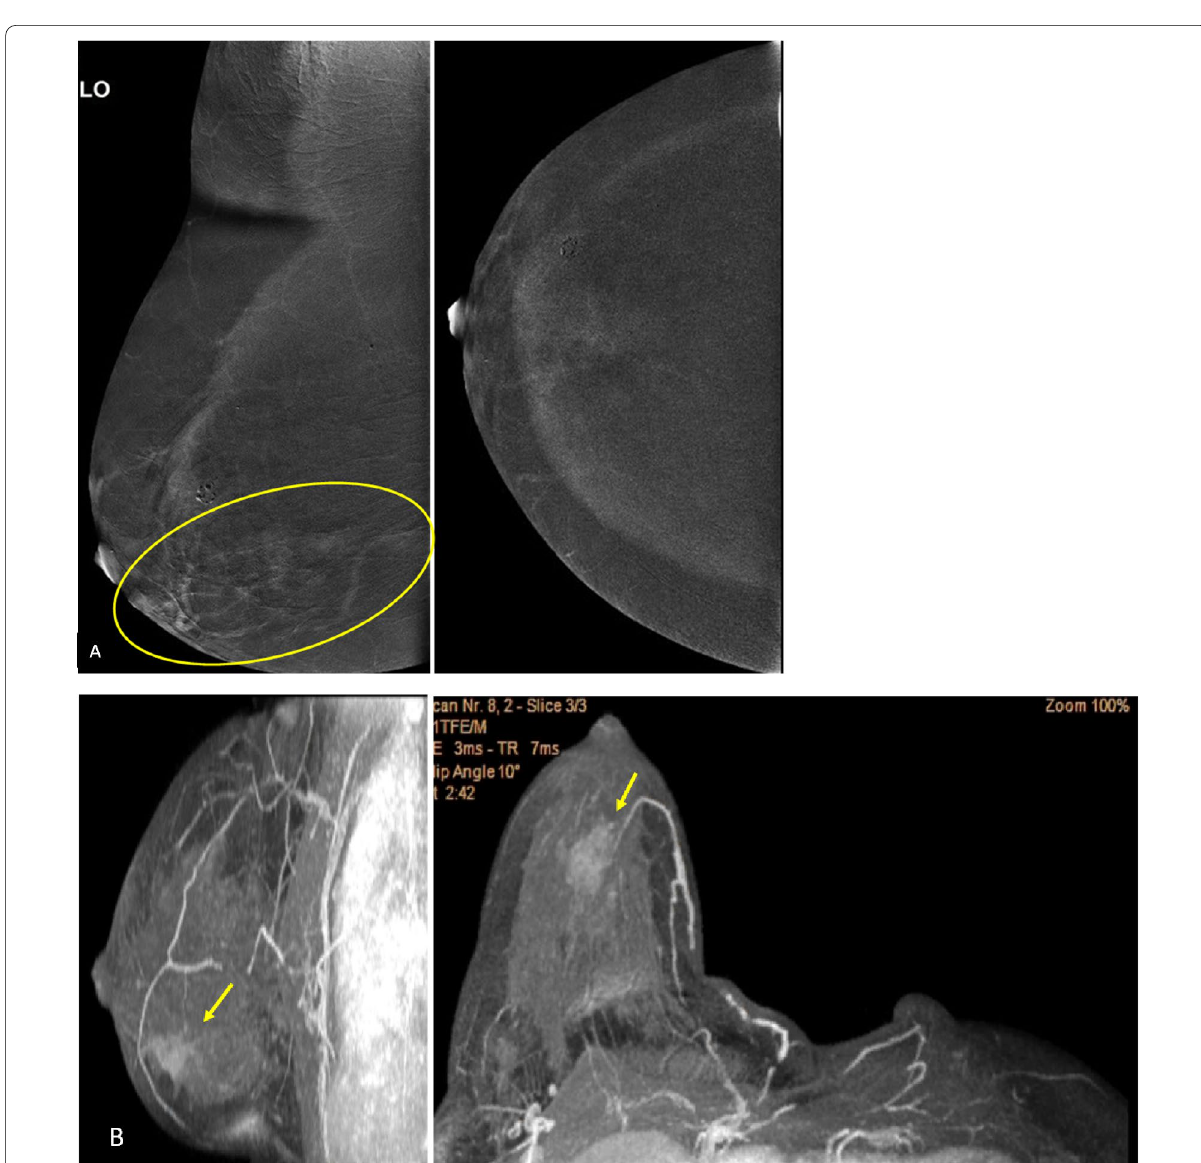
Fig. 7 Known case of left breast cancer post-mastectomy. a CEM of the right breast MLO and CC views that showed faint and vague contrast uptake at the lower portion of the breast (circle) that was not obvious at the CC view. b Further scanning by post-contrast MR imaging displayed evident focal area of non-mass enhancement easily depicted at the sagittal and axial reformatted 3D maximum intensity projection images (arrows). MRI was the modality that confirmed the possibility of contralateral carcinoma